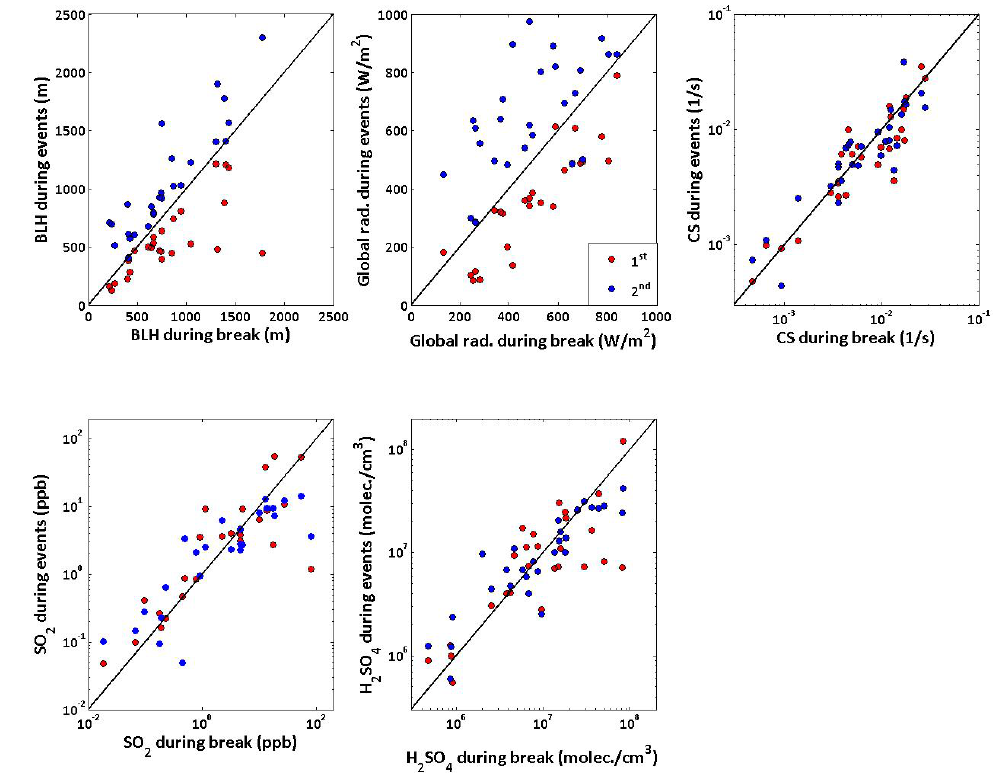
Fig. 2. Median values for the mixing layer height (BLH), global radiation, SO 2 and H 2 SO 4 proxy concentrations and CS during the first (red markers) and the second (blue markers) nucleation and growth event of the day versus the corresponding parameters during the break between the events. Days from Marikana and Botsalano, when air masses’ origin of successive growing modes had the same origin, were included